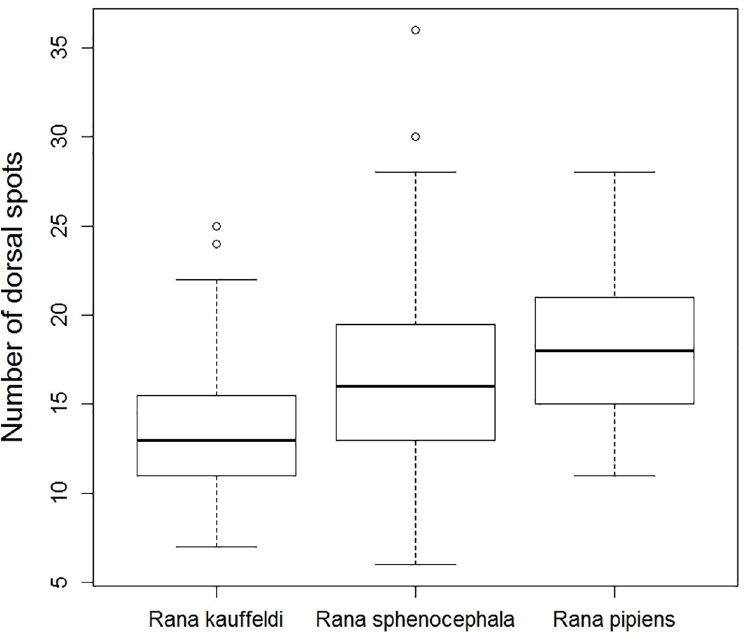
Fig 4. Boxplot of number of dorsal spots for three species of leopard frogs in the northeastern US. Open circles are statistical outliers.